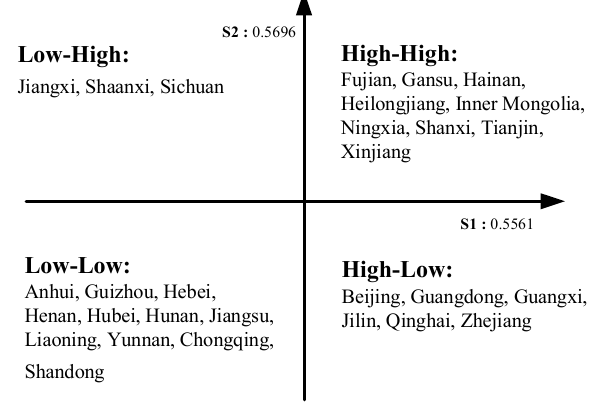
Figure 4. Province distribution by mining production and land rehabilitation stages.